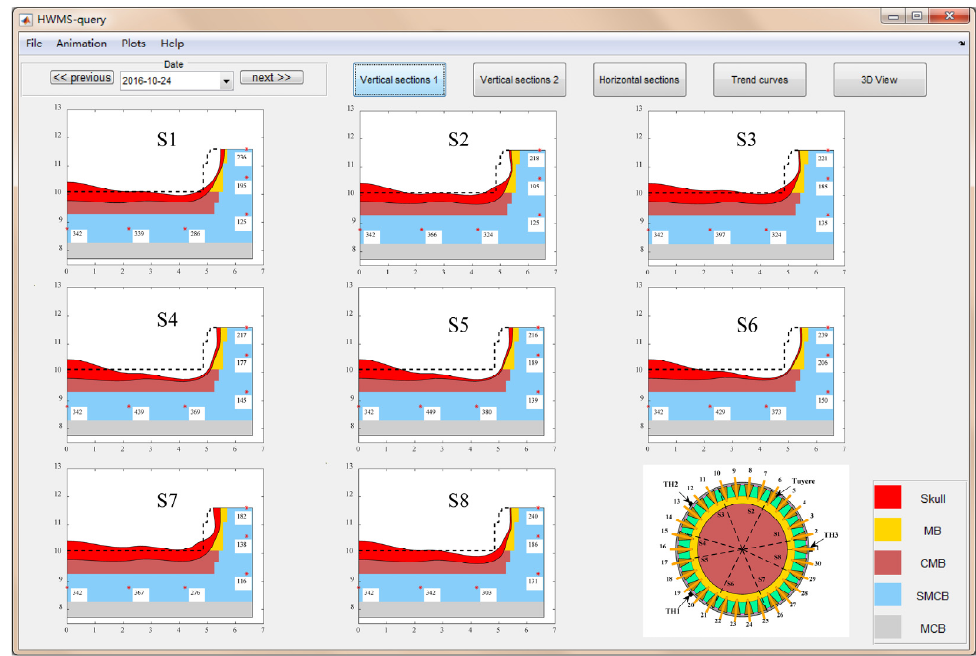
Figure 3. Skull and erosion profiles in the eight vertical sections (cf. S1–S8 in Figure 1b) of the blast furnace hearth for a selected